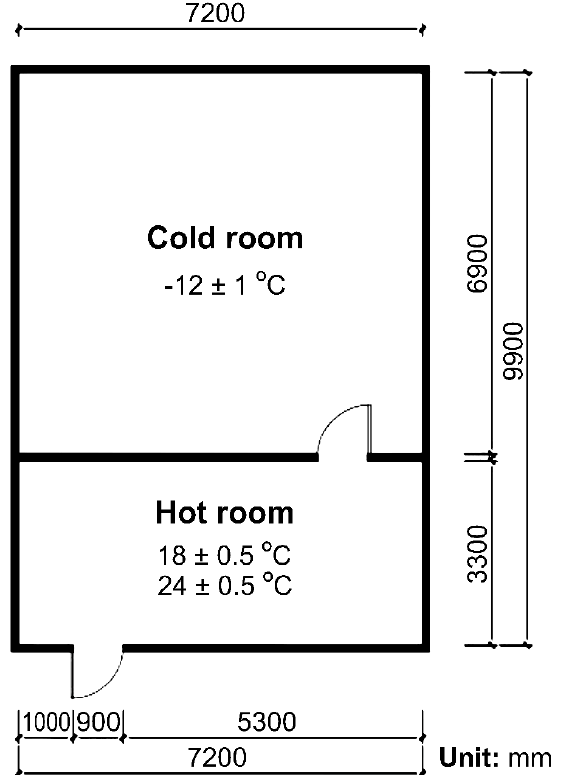
Figure 1. Floor plan of the room under experimental